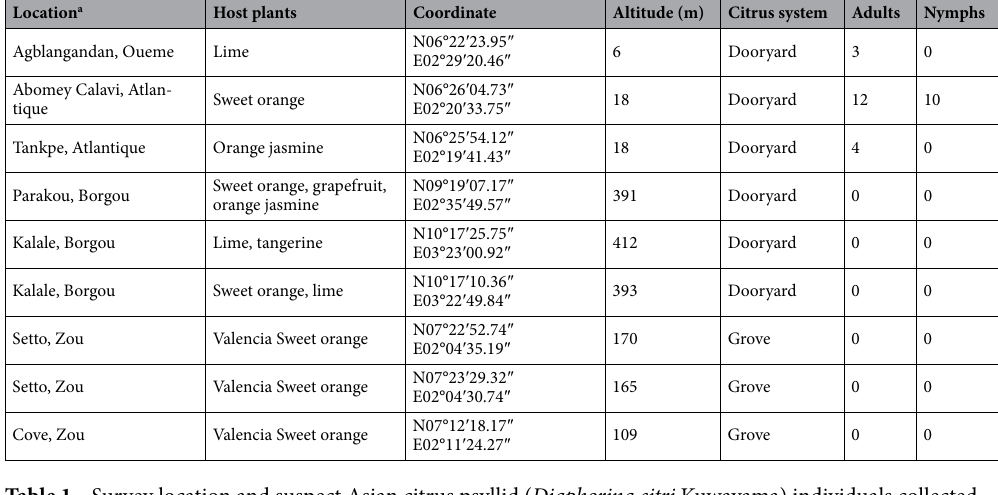
Table 1. Survey location and suspect Asian citrus psyllid ( Diaphorina citri Kuwayama) individuals collected from host trees Benin Republic, West Africa. a City,